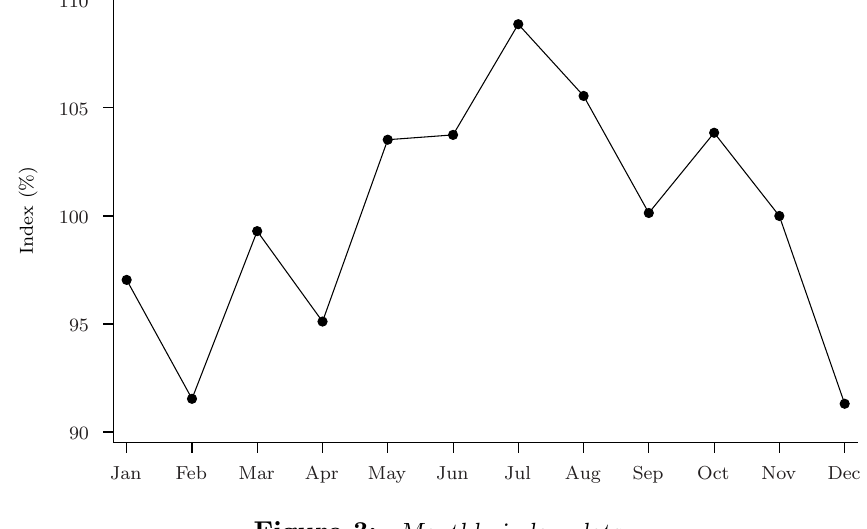
Figure 3: Monthly index